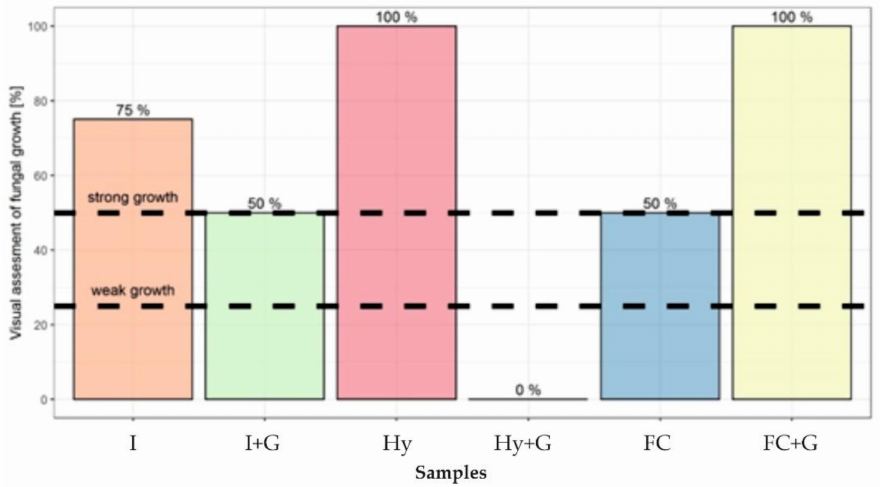
Figure 5. The assessment of antifungal activity for the different non-modified and modified nonwo- vens is shown, namely for (I) initial state, (I + G) initial state and graphene, (Hy) hydrophilic agent, (Hy + G) hydrophilic agent and graphene, (FC) functional coating and (FC + G) functional coating and graphene.